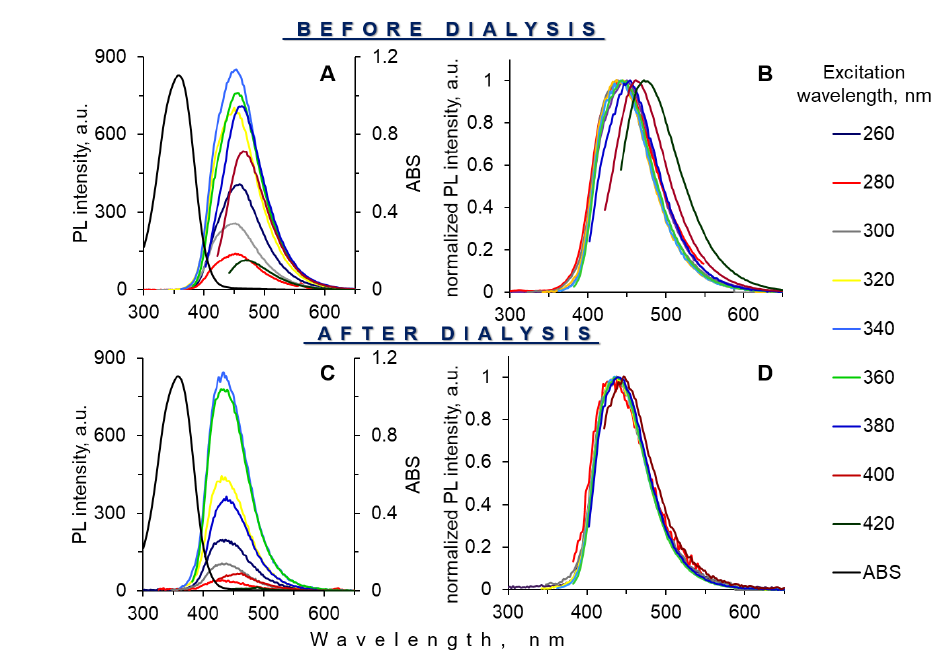
Figure 5. Absorption (black) and luminescence spectra ( A , C ), normalized luminescence spectra ( B , D ) of composite nanoparticles before and after dialysis,